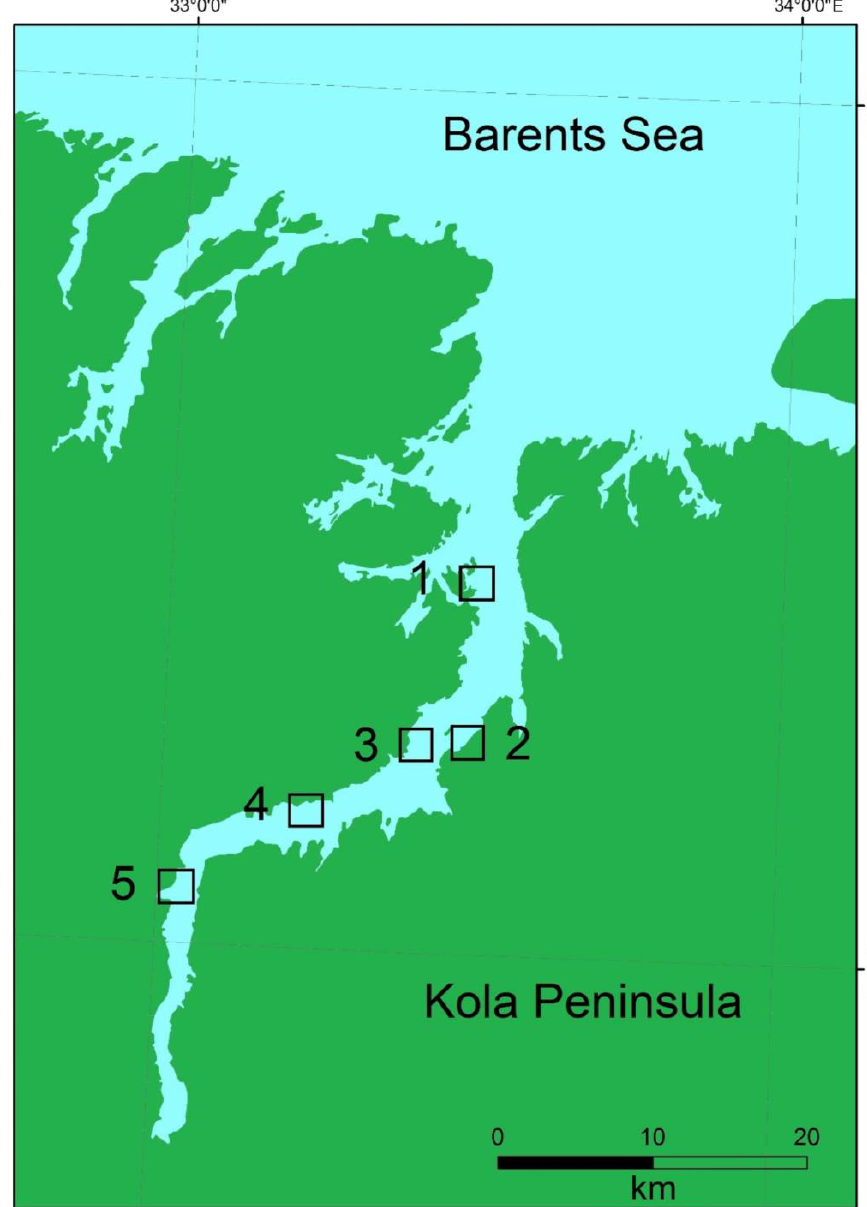
Figure 1. Location of the sampling sites in Kola Bay. It is a typical 51-km long fjord with its width gradually decreasing from 3.0 – 3.5 km near its mouth to 1.5 – 2.5 km in the center to 1.0 – 1.5 km at its southern end [39]. It ex- tends up to 60 km into the mainland and has two bends dividing the area into three parts: northern, middle, and southern. The depth increases from the apex to the mouth of the basin with a maximum of 321 m. Kola Bay is separated from the open sea by a sill at 104 m water depth. Bottom substrata vary from silt or sandy silt and muddy sand at deeper sites to sand, pebbles, and rocks at sites with high water flow velocity [40]. Two rivers flow into the apex of the bay, and the main interactions between the river and seawater occur in the southern part of the area. Fresh water is slightly mixed with sea- water and forms a thin layer on the surface in the middle and northern parts of Kola